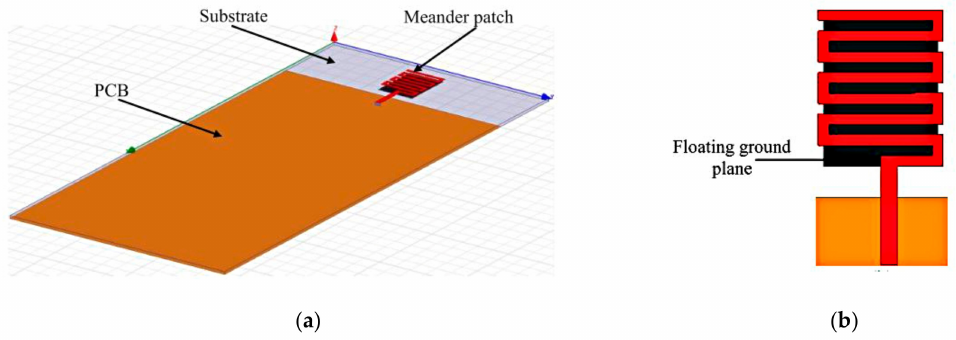
Figure 16. The meander antenna. ( a ) Perspective view. ( b ) Meander patch [50]. A summary of frequency reconfigurable antenna techniques using conductive